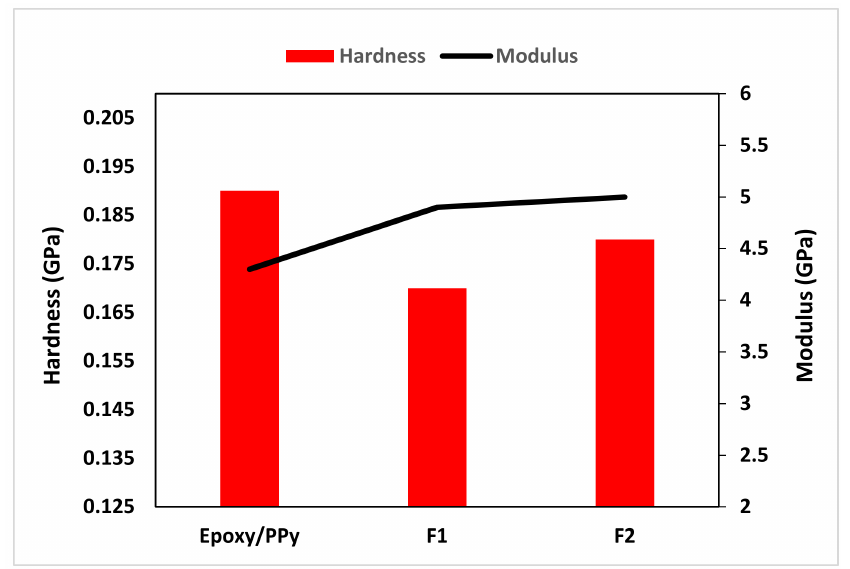
Figure 5. Nanoindentation analysis for the fabricated epoxy / PPy, F1, and F2